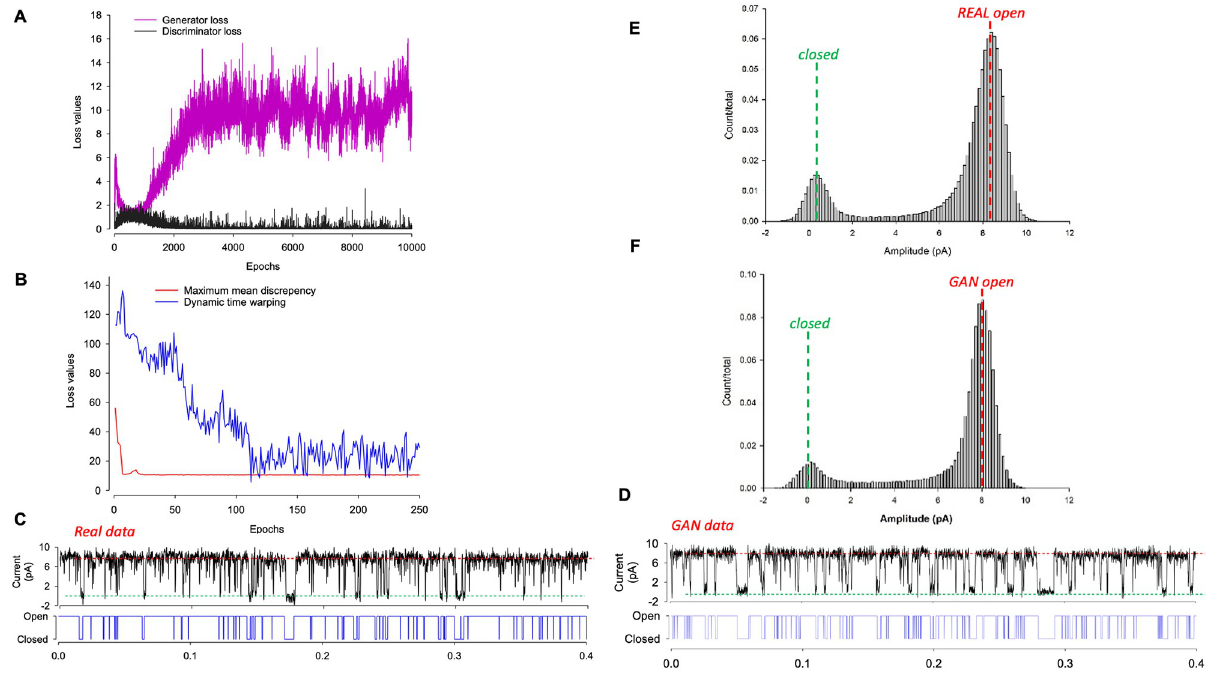
Fig 3. Realistic labelled single molecule data are synthesised by DeepGANnel. (A) Discriminator and Generator losses plotted per epoch during training. (B) The maximum mean discrepancy (MMD) and dynamic time warping (DTW) evolution over the first 250 epochs as they approach equilibrium. (C and D) Examples of real (C) and GAN synthesised (D) labelled data records. (E and F) All points amplitude histograms calculated from the real (E) and GAN synthesised (F) data.